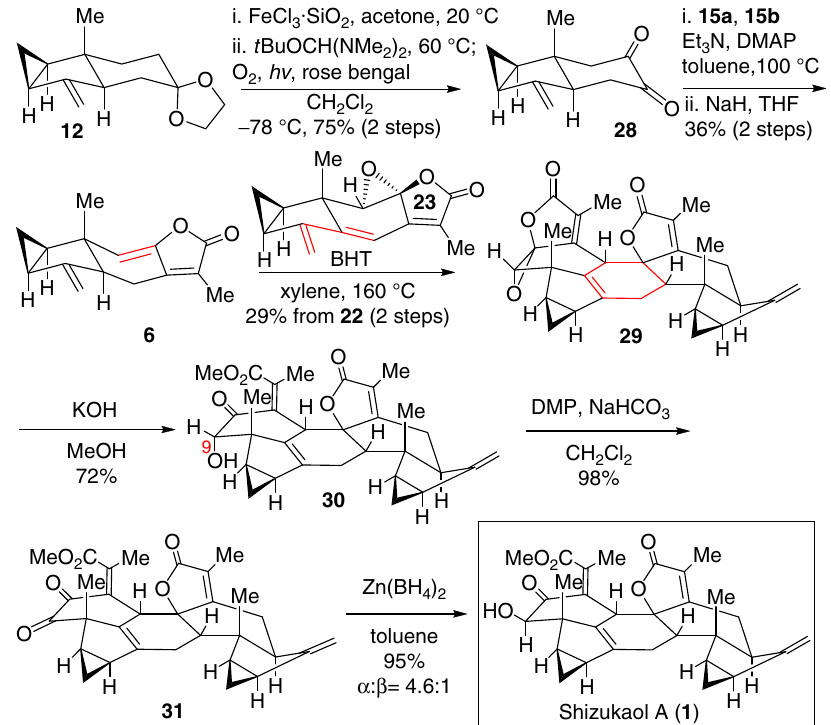
Fig. 7 Total synthesis of shizukaol A ( 1 ). DMAP 4-dimethylaminopyridine, BHT butylated hydroxytoluene, DMP Dess – Martin